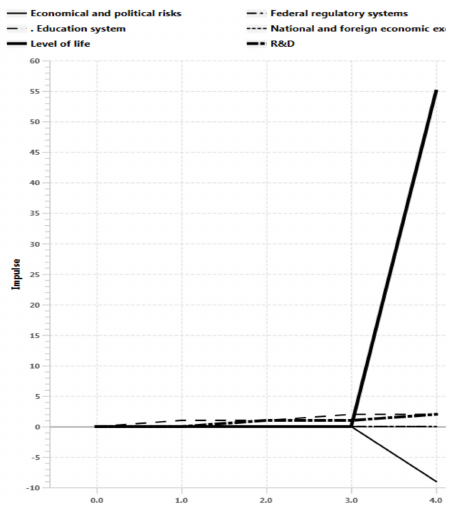
Figure 9. The graph of impulse processes at the selected vertices V6, V7, V10, V12, V16, V20 Scenario " Improving the conditions of higher education system in the region" disturbing momentum q10 = + 1.